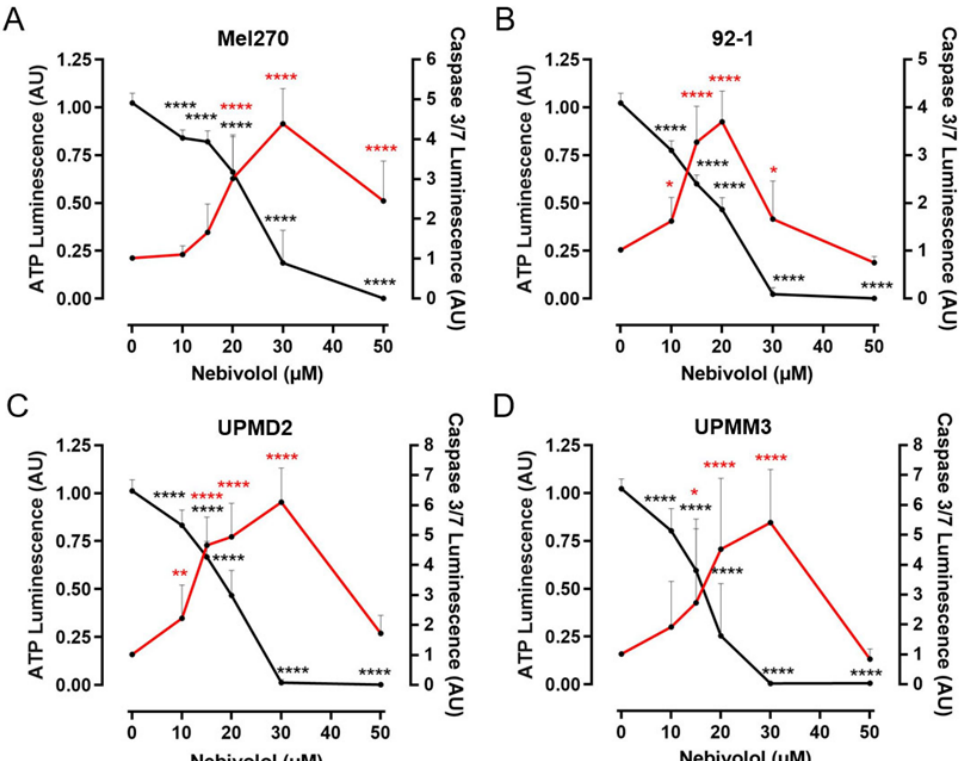
Figure 5. Early apoptotic effects and viability change of nebivolol in various 3D tumor spheroid models. Spheroids were generated from cell lines ( A ) Mel270 and ( B ) 92-1, or primary cell lines ( C ) UPMD2 and ( D ) UPMM3. Spheroids were treated once with nebivolol at the indicated concentration. Early apoptosis was assayed with a caspase 3/7 luminescence assay after incubation with nebivolol for 48 h (red line). Corresponding viability was assayed with an ATP luminescence assay (black line). The luminescence of the treated spheroids was normalized to the luminescence of the control spheroids (0 µ M nebivolol) and is given in arbitrary units (AU). The means ± SD of three independent experiments for each UM tumor spheroid type with n = 6 spheroids for each condition are shown. Statistical analysis was conducted using one-way ANOVA and Tukey’s multiple compar- isons test; the significance levels of the treated spheroids in relation to the control spheroids (0 µ M nebivolol) are displayed. Significance levels are indicated at * p < 0.05, ** p < 0.01, **** p <